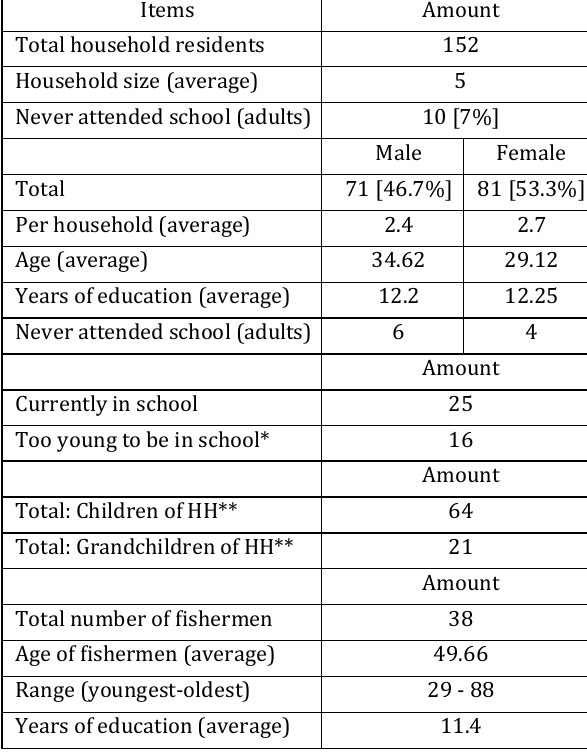
Table 2. Household information gathered through